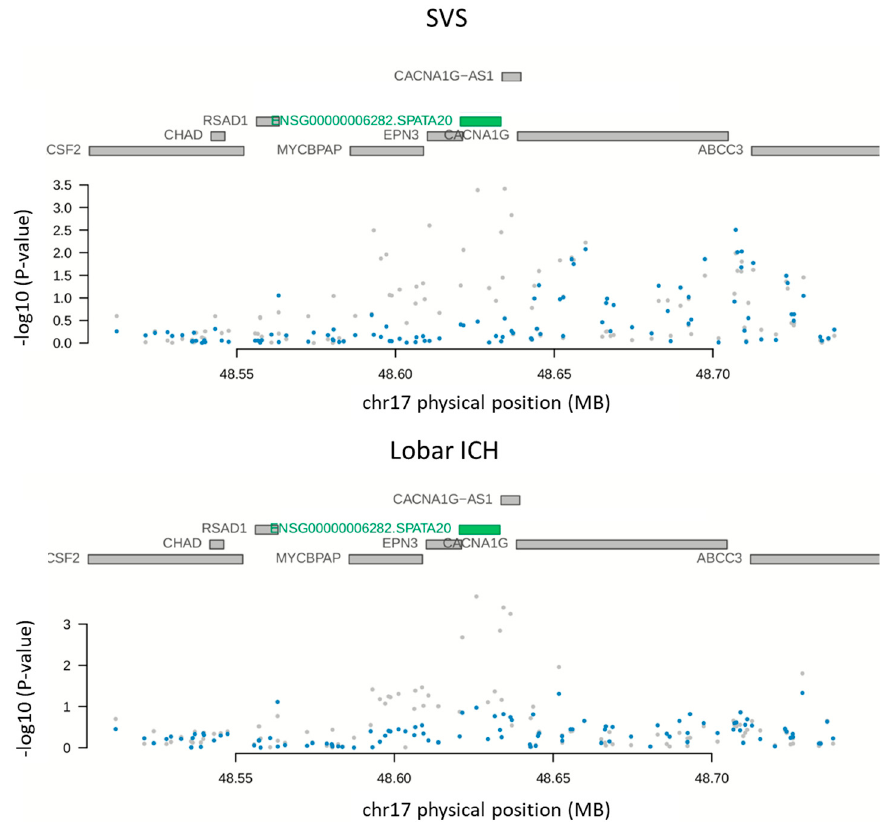
Figure 3. GWAS results before conditioning by the SPATA20 levels (grey) or after conditioning by protein levels (blue).